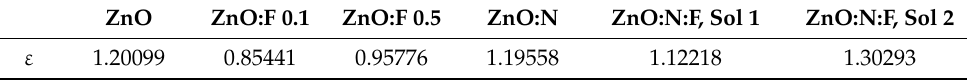
Figure 10. FESEM micrographs of ( a ) ZnO:F 0.1 and ZnO:F 0.5 films at magnification 1000, ( b ) ZnO:F 0.1 and ZnO:F 0.5 films at magnification 20,000, ( c ) ZnO:F 0.1 and ZnO:F 0.5 films at magnification 40,000 and ( d ) ZnO:F 0.1 and ZnO:F 0.5 films at magnification 80,000. The fluorine–doped ZnO films are thermally treated at 600 ◦ C. Table 3. Microstrain values, estimated for sol-gel ZnO and doped ZnO films. ZnO ZnO:F 0.1 ZnO:F 0.5 ZnO:N ZnO:N:F, Sol 1 ZnO:N:F, Sol